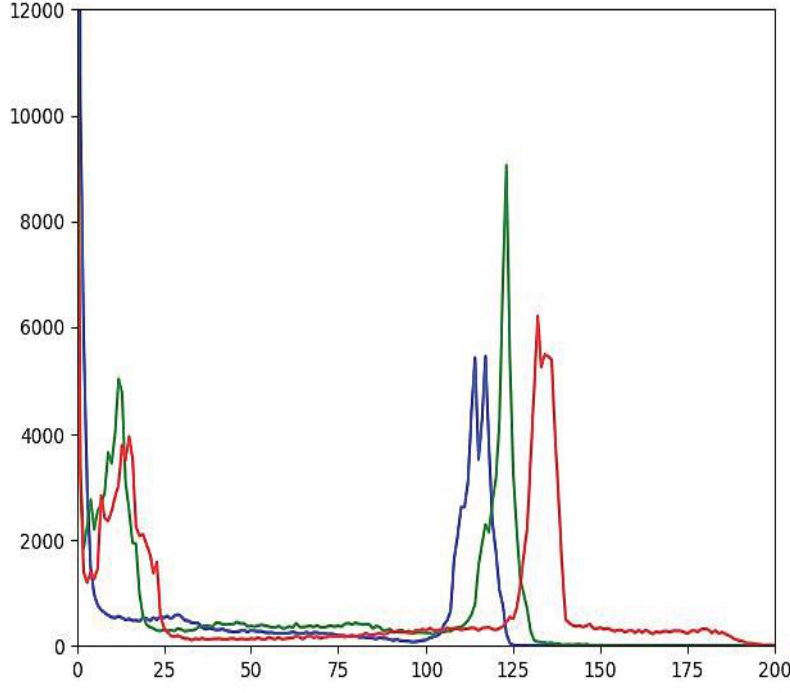
Figure 12. Histogram of the RGB graph for the image (see Figure 11).